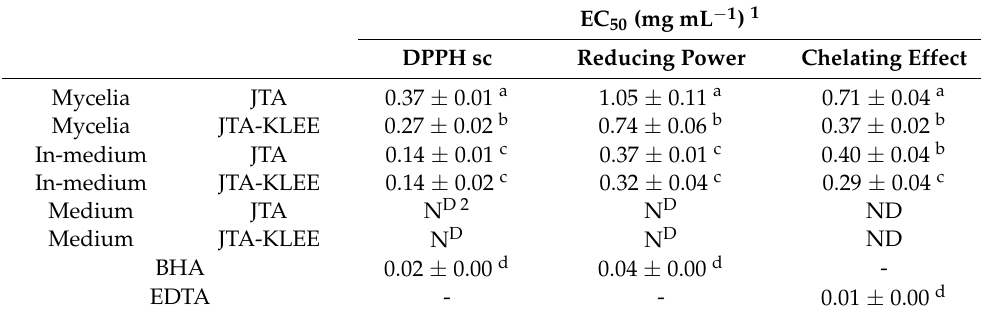
Figure 2. Antioxidant activity assays of MEs of A. cinnamomea mycelia, inoculated medium (in-medium), and fresh medium. ( a ) DPPH free radical-scavenging effects. ( b ) Reducing power of ferrous ions. ( c ) Ferrous ion-chelating effects. The MEs of A. cinnamomea mycelia from cultured on JTA. Each value is expressed as the mean ± SD ( n = 3). Table 2. EC 50 values for MEs from A. cinnamomea mycelia, inoculated medium (in-medium), and fresh